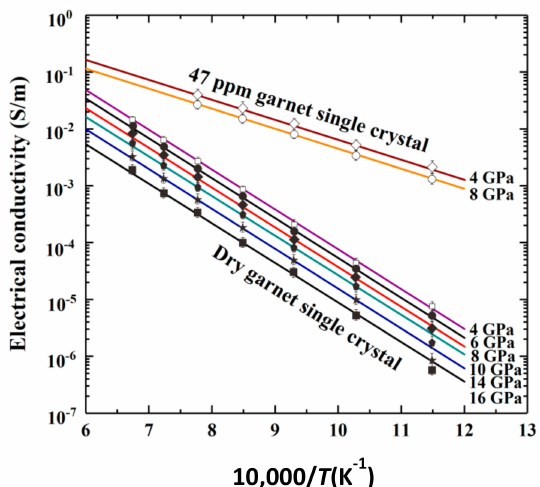
Figure 9. The e ff ect of the pressure on the EC of anhydrous and hydrous pyrope-rich garnet single crystals (~Py 73 -Alm 14 -Grs 13 ) in the temperature range of 873–1473 K. The abbreviations Alm and Grs stand for almadine (Fe-Al) and grossular (Ca-Al) garnet, respectively (Reproduced with permission from Dai and Karato, Phys. Earth Planet. Inter.; published by Elsevier, 2009